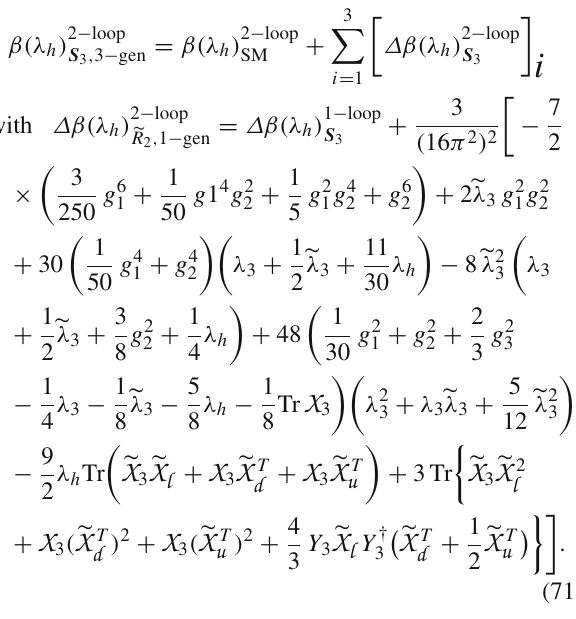
one-generation model of S 3 loses stability at two-loop order, although the three-generation scenario remains stable. However, if we consider Y φ > 3 . 9, the three-generation scenario of the S 3 model also leaves the stable region at two-loop